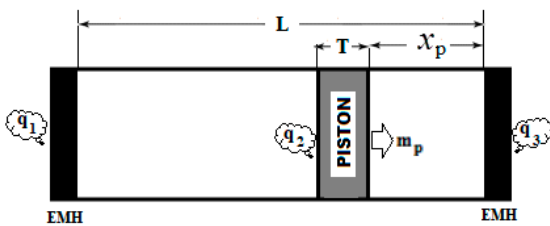
Figure 14. An idealized physical model of a dual ‐ head EMP device for the UAV.